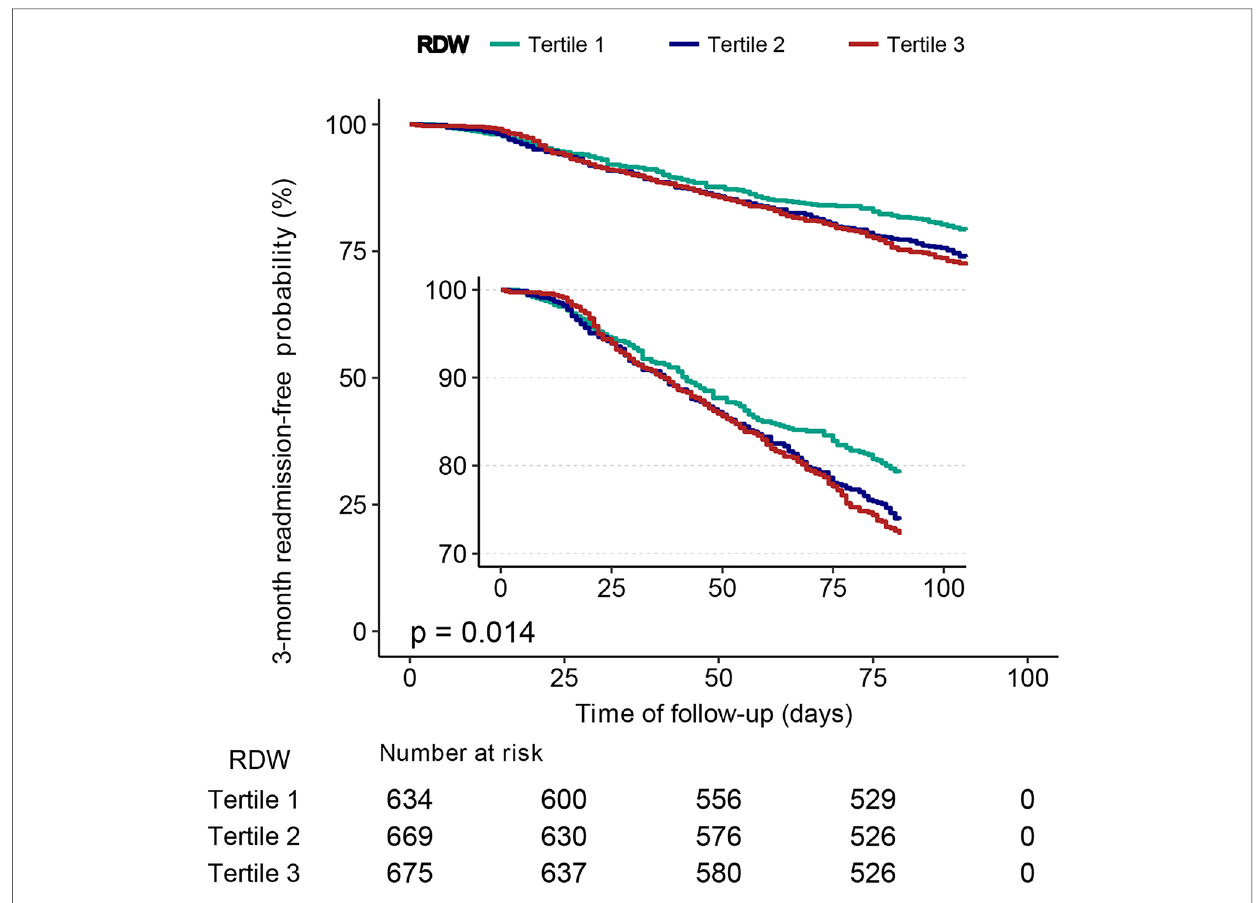
FIGURE 3 Kaplan – Meier curves for 3-month readmission-free probability in the patients with heart failure for categories of RDW tertiles. RDW, red cell distribution